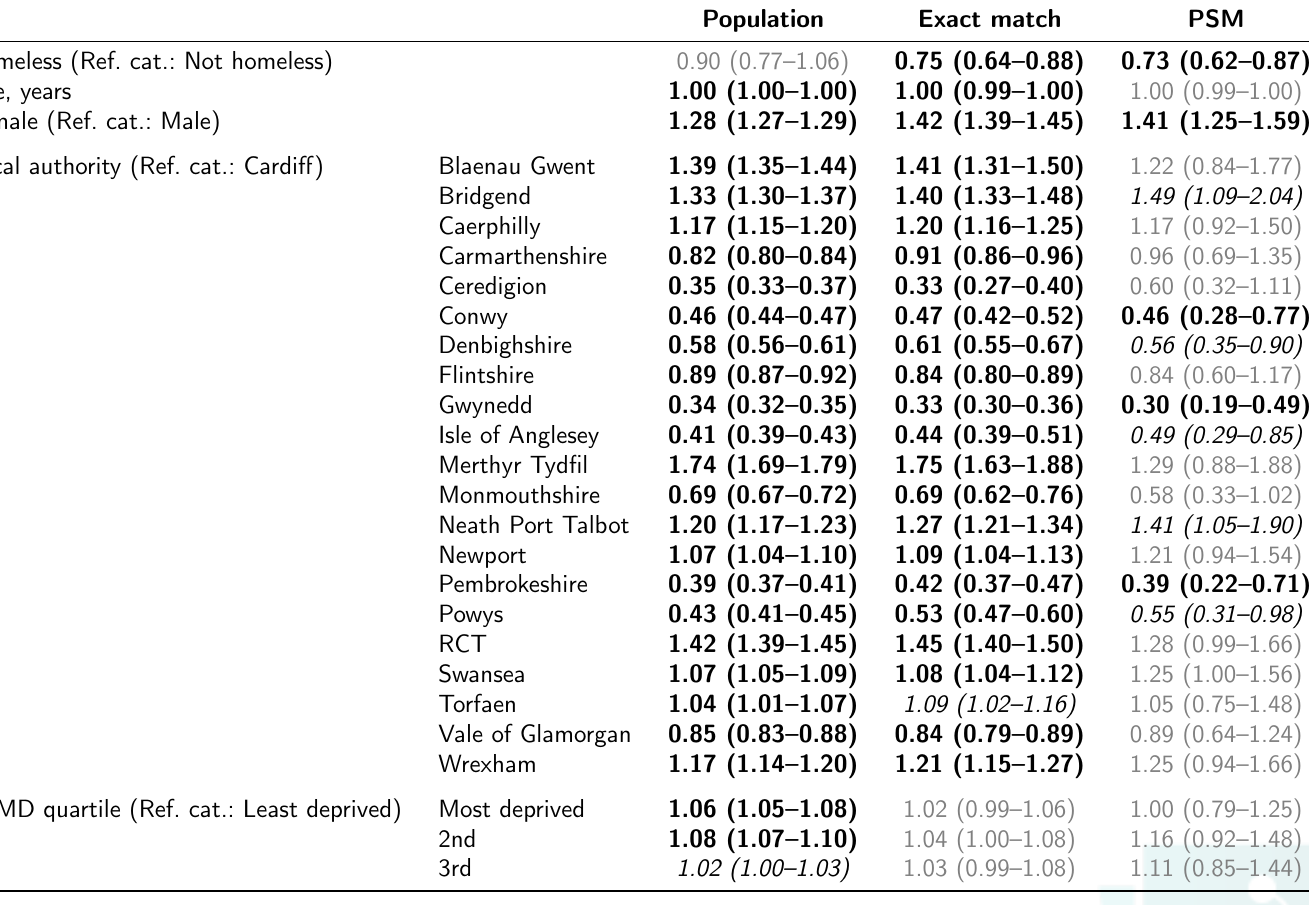
Table 4: Effect of characteristics on the odds of SARS-CoV-2 infection, by not-homeless control group included in logistic regression